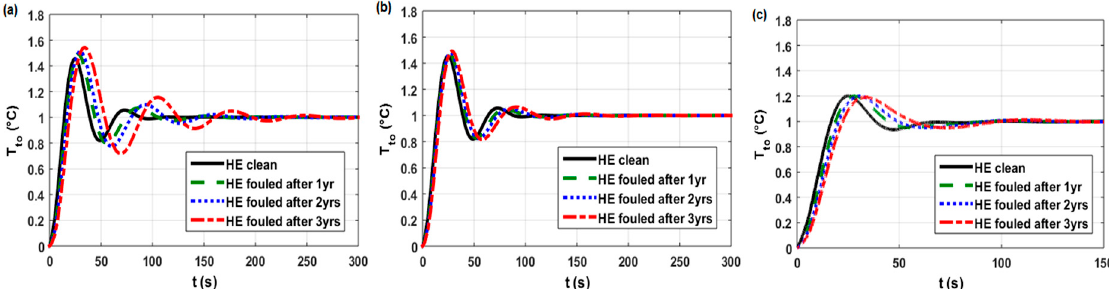
Figure A2. Closed-loop step responses (case in work [6]) under fouling conditions of the HE E15AB models: without adjustment ( a ) after adjustment ( b ) and after adjustment of optimal ( c ) PID tuning parameters.